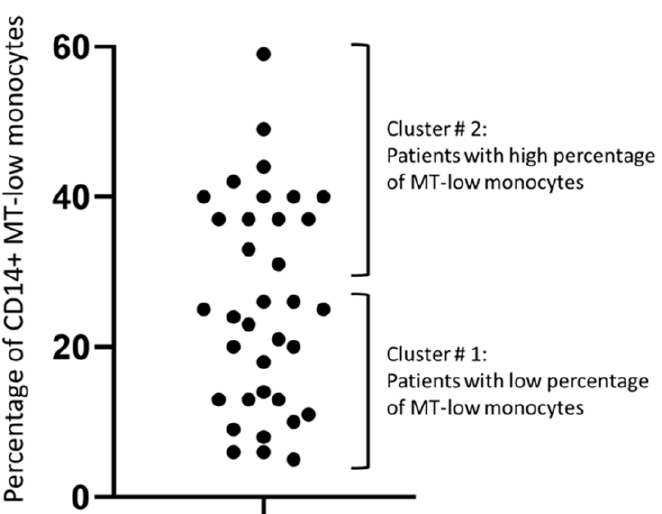
Figure 5. Bimodal distribution of patients by the proportion of MitoTracker-low monocytes allows distinguishing two clusters. MT, MitoTracker.